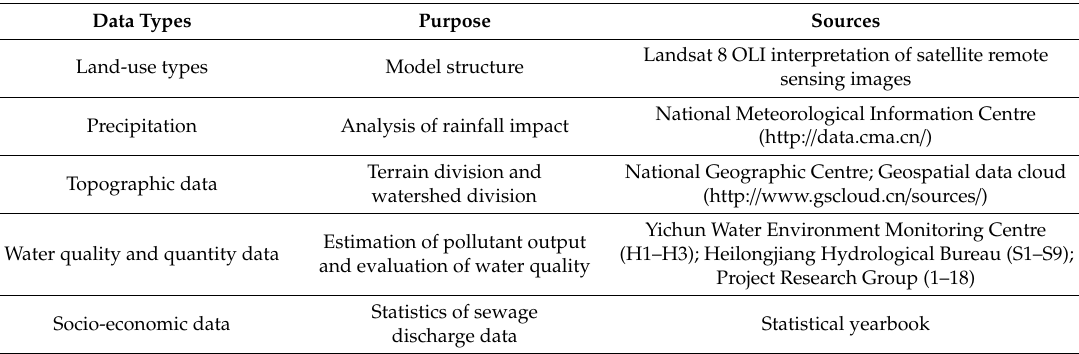
Table 2. Main data sources and